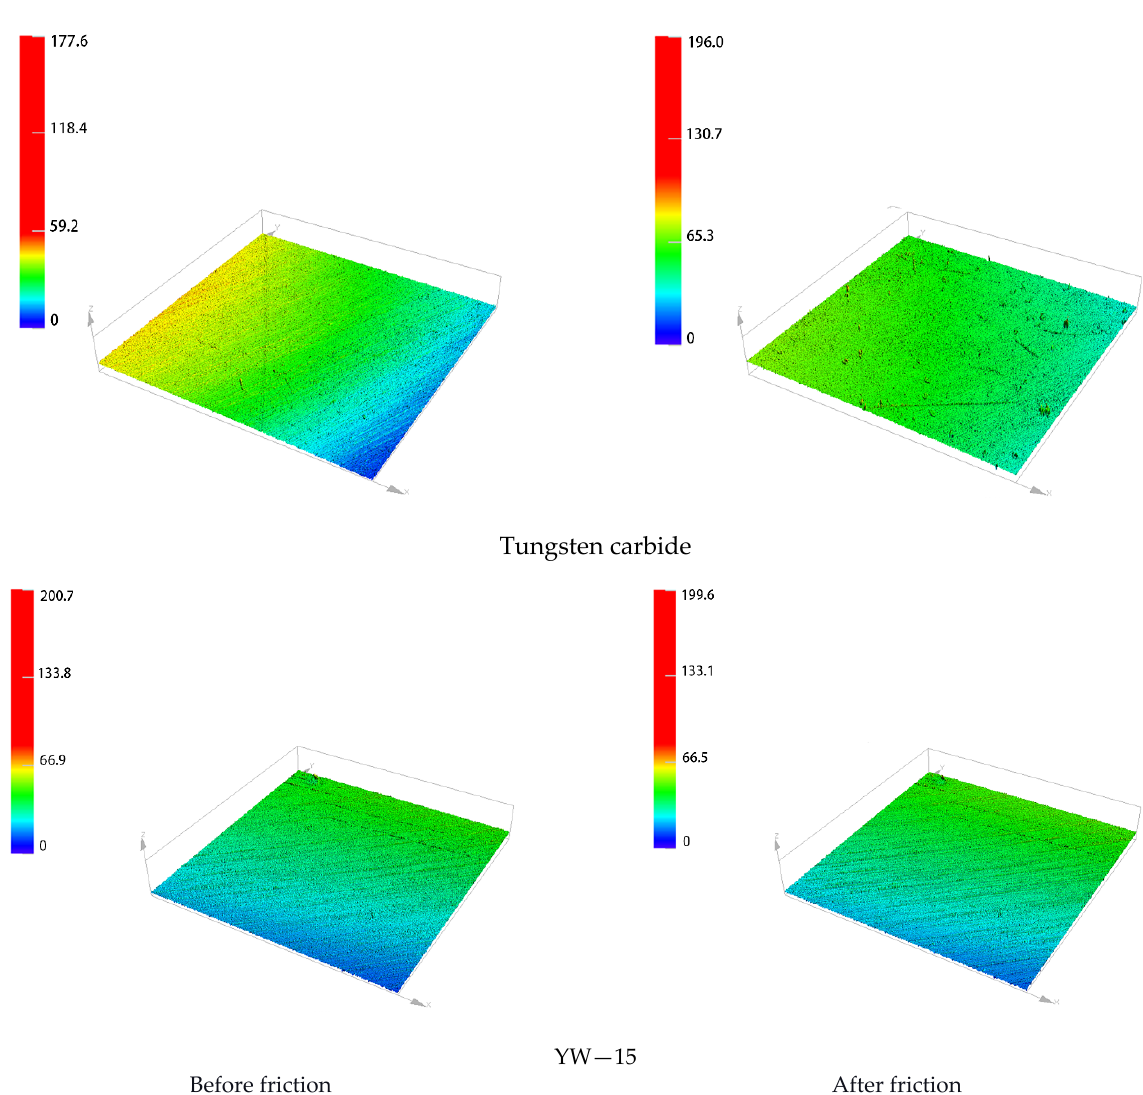
Figure 11. Three-dimensional morphology of metal surface before and after friction (using a tenfold magnifying glass).